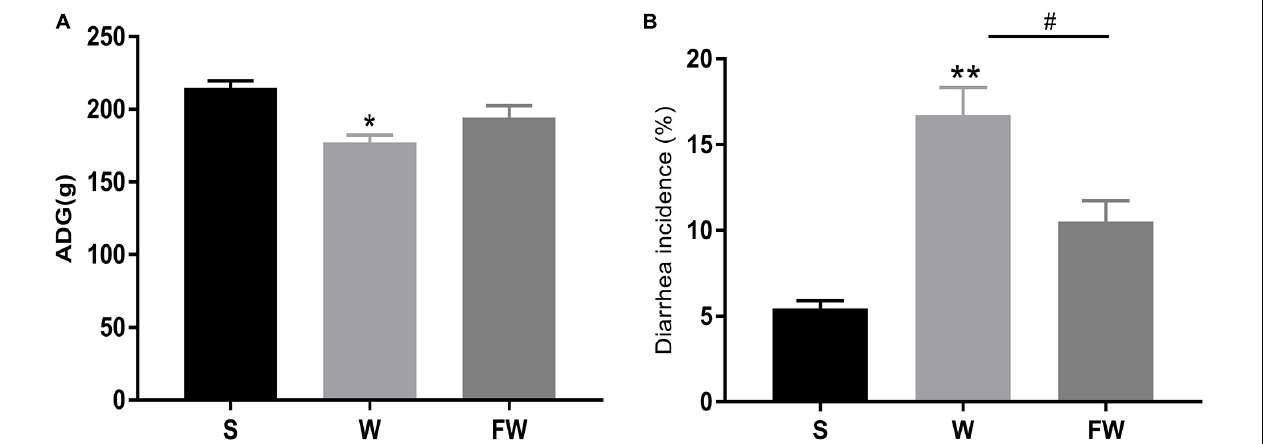
FIGURE 5 | ADG (A) and diarrhea incidence (B) of group S, W, and FW. The symbol “*” represented that the W and FWs group were compared with the S group, the symbol “#” represented that the FW group was compared with the W group. Data were shown as mean ± SEM (* p < 0.05, ** p < 0.01, and # p < 0.05) (S, Sucking; W, Weaned; FW: FMT+Weaned). (1) ADG was calculated as weight gain (final body weight-initial body weight) divided by the number of treatment days. (2) The incidence of diarrhea (%) was calculated as the total number of diarrheal piglets during the period divided by the total number of piglets multiplies duration of the